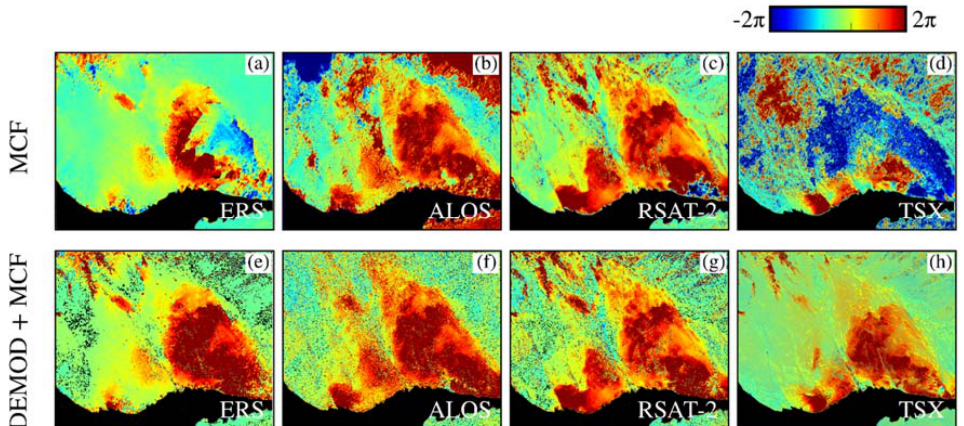
Figure 7. ( a – d ) Standard MCF unwrapping results of four test interferograms (( a ) ERS, ( b ) ALOS-1, ( c ) RADARSAT-2, and ( d ) TerraSAR-X Staring Spotlight) over the Fels Glacier Slide. ( e – h )